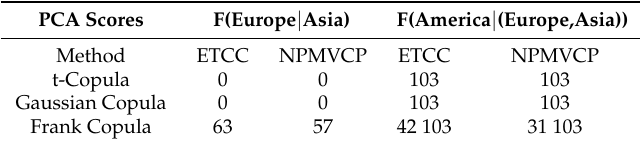
Table 17. Change point detection by ETCC and NPMVCP of PCA and copulas with real exchange currency data (1/3/2013 to